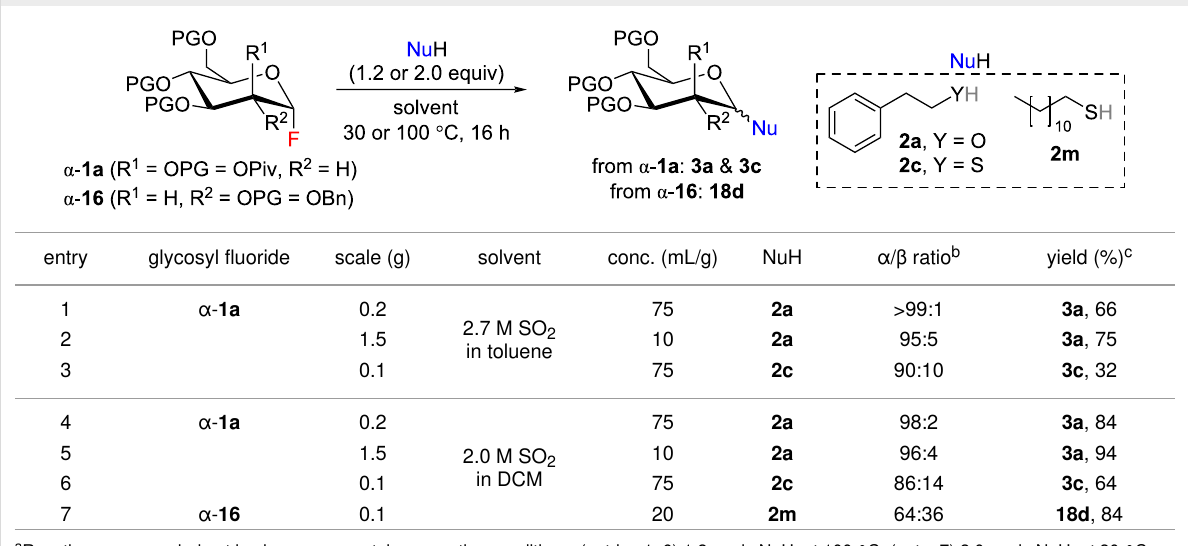
Table 5: Glycosylation with mannosyl fluoride α - 1a and glucosyl fluoride α - 16 in saturated SO 2 solutions. a